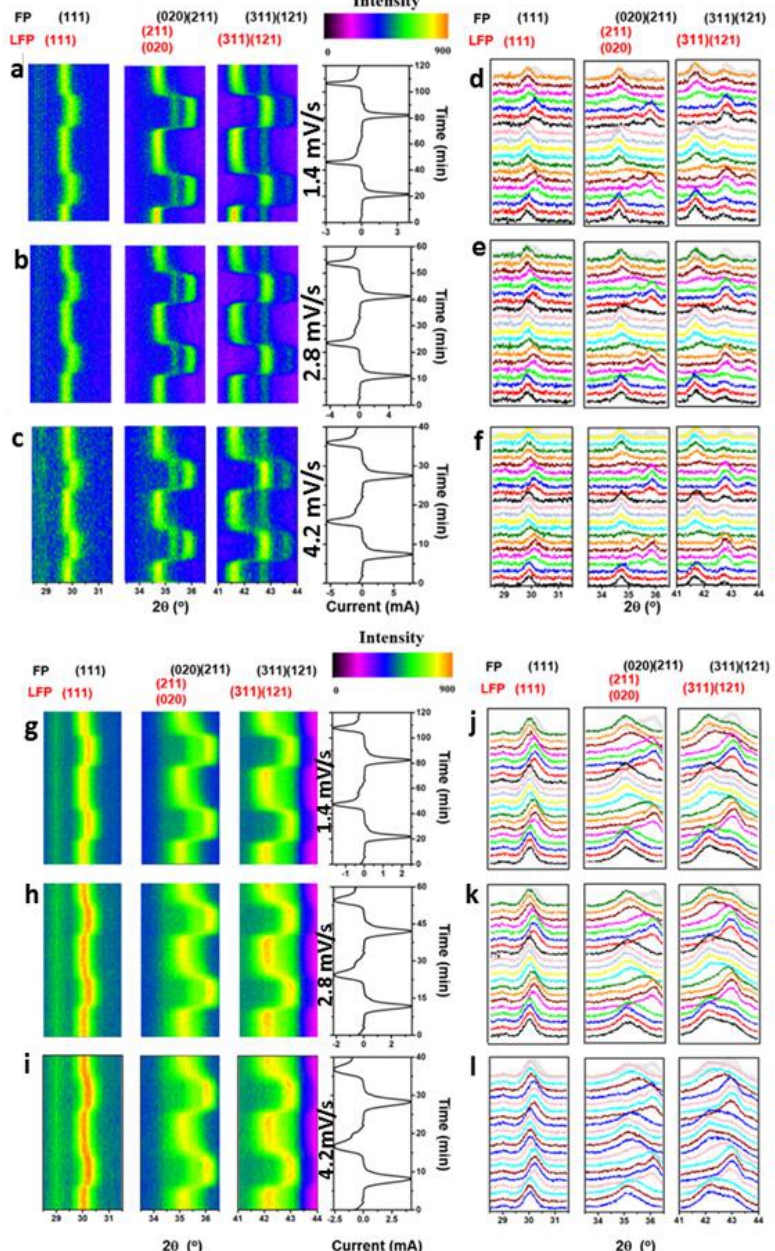
Figure 4. Image plots ( a – c ) and corresponding XRD spectra ( d – f ) of cells cycled at 1.4, 2.8, and 4.2 mV/s at 20 °C. Image plots ( g – i ) and corresponding XRD spectra ( j – l ) of cells cycled at 1.4, 2.8, and 4.2 mV/s at 0 °C [147]; with permission from Elsevier.